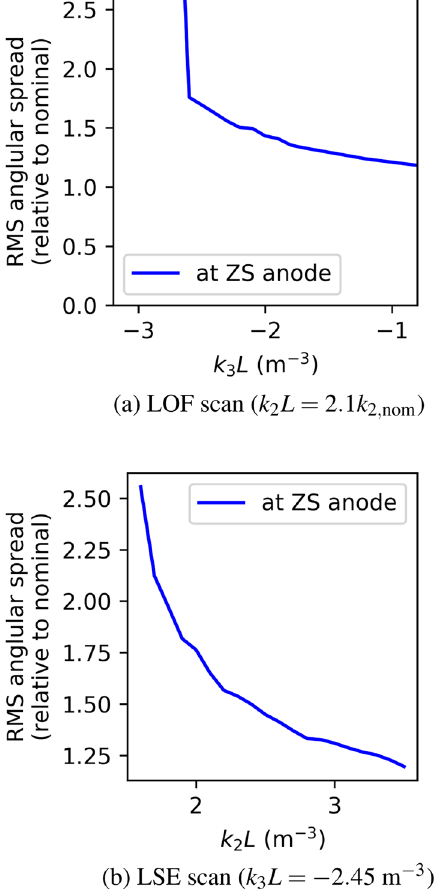
FIG. 14. Simulated angular spread impacting the ZS anode wire-array as a function of the LSE and LOF strength